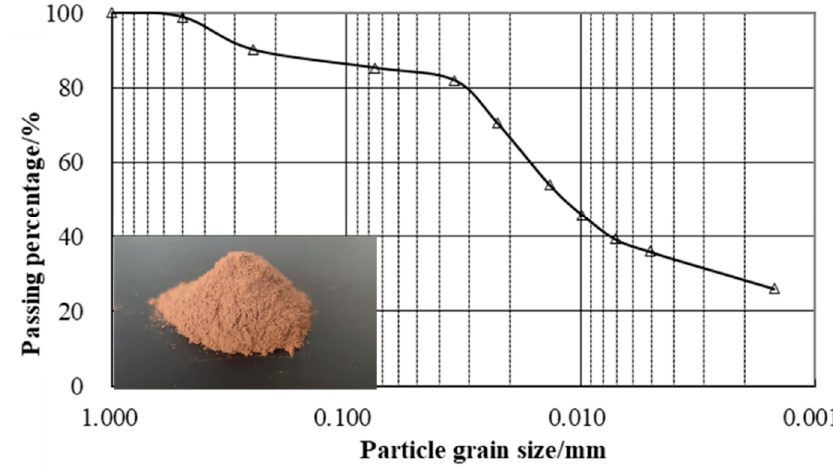
Figure 2. Particle size